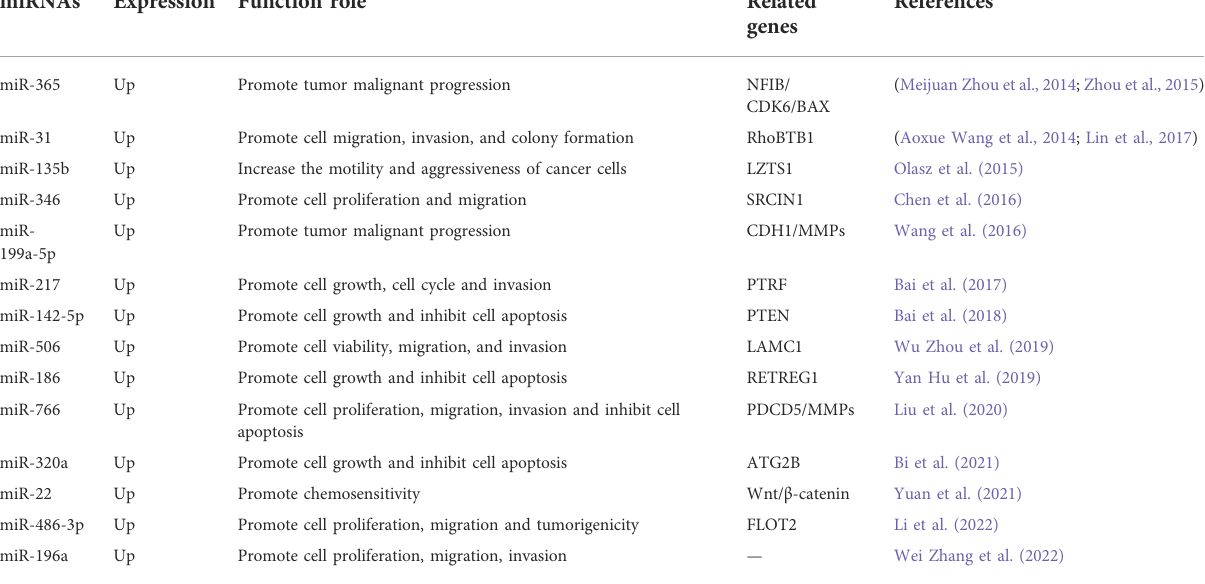
TABLE 2 Functional characterization of upregulated miRNAs in cutaneous squamous cell carcinoma. miRNAs Expression Function role